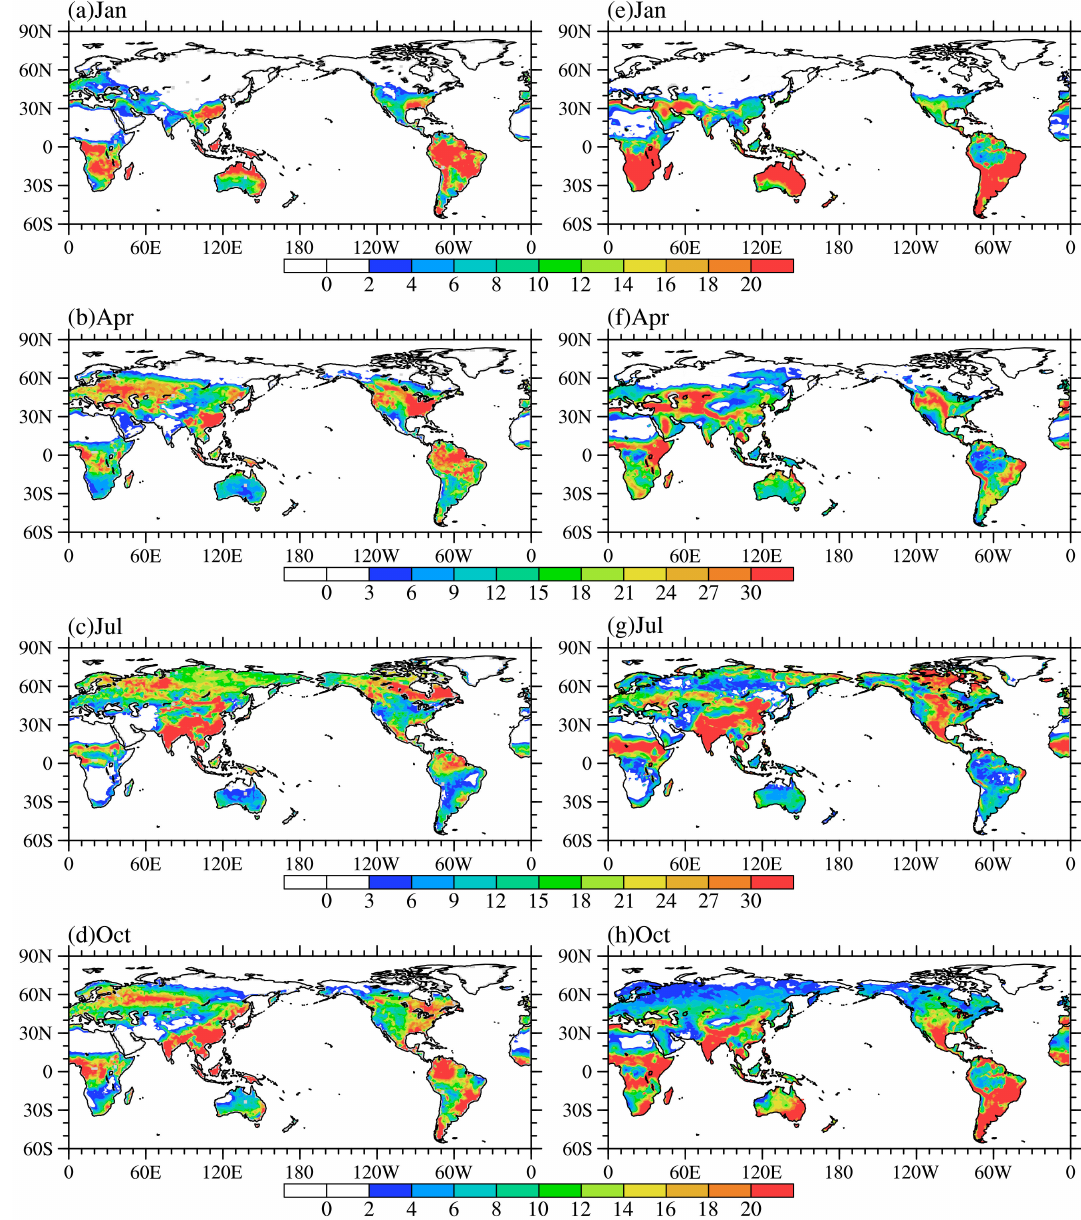
Figure 8. Spatial distribution of global Es (units: W/m 2 ): ( a – d ) CFSR reanalysis data and ( e – h ) simulated by